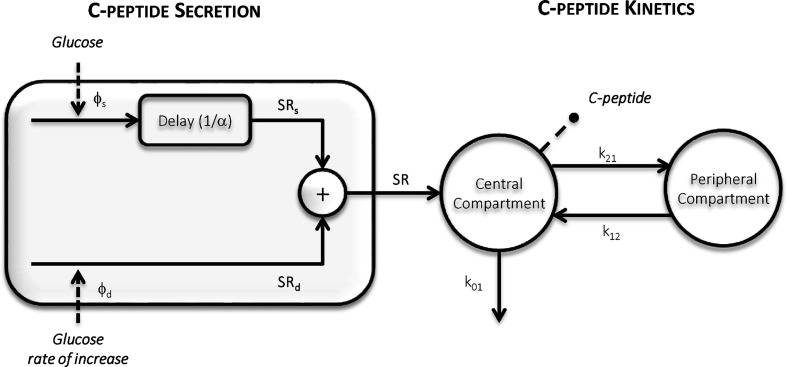
The Oral C-peptide Minimal Model (OCMM) (11, 18) with its secretion (left) and kinetics (right) components. SR is the pancreatic secretion, Φs and Φd static and dynamic β-cell responsivity indices respectively, 1/α time constant of the static component, and k01, k12, and k21 C-peptide kinetic parameters.